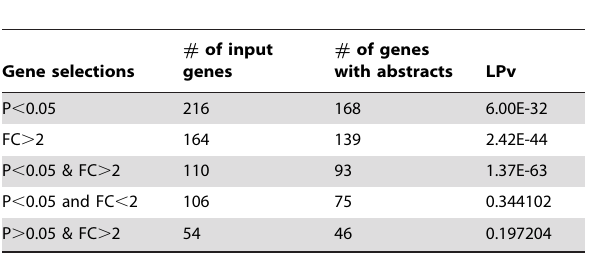
Table 4. LPv for different gene lists identified by microarray analysis.